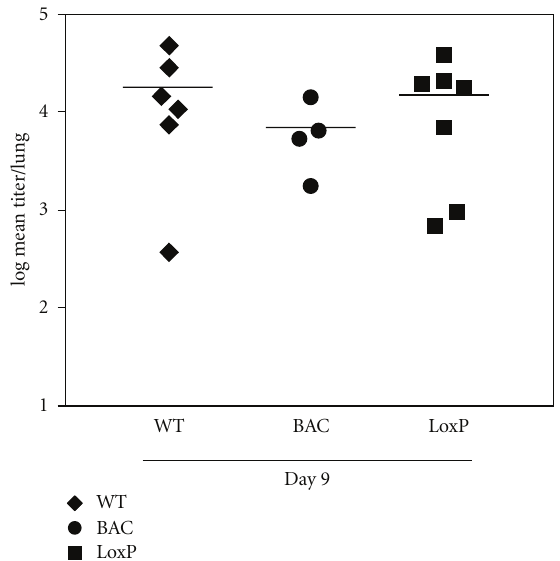
Figure 3: Infection of pMHV-68(BAC)v and MHV-68(loxP) produced similar viral titers to wild-type MHV-68 in lungs of mice. Balb/c mice were infected with 20 PFU of each virus via intranasal inoculation. At day 9 after infection, the lungs were harvested and homogenized for determining viral titers using plaque assays. Each symbol represents the lung titer of individual